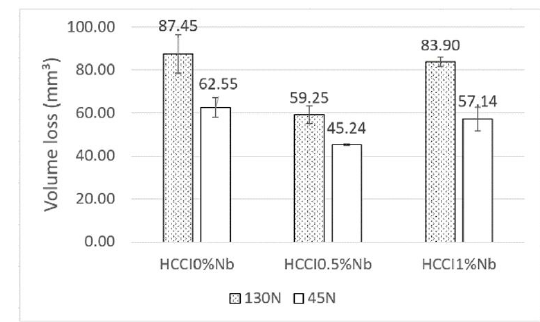
Figure 10. Volume loss after 60 minutes of